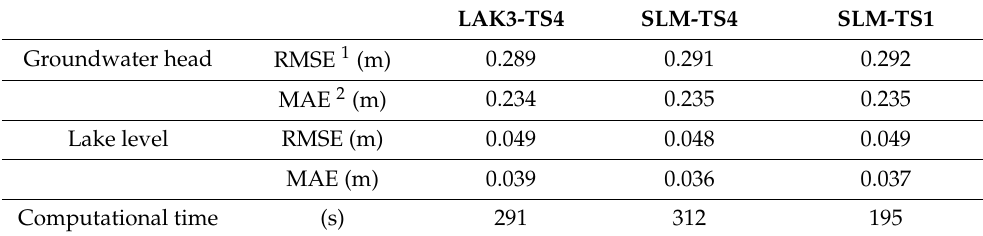
Table 1. Model performance and computational